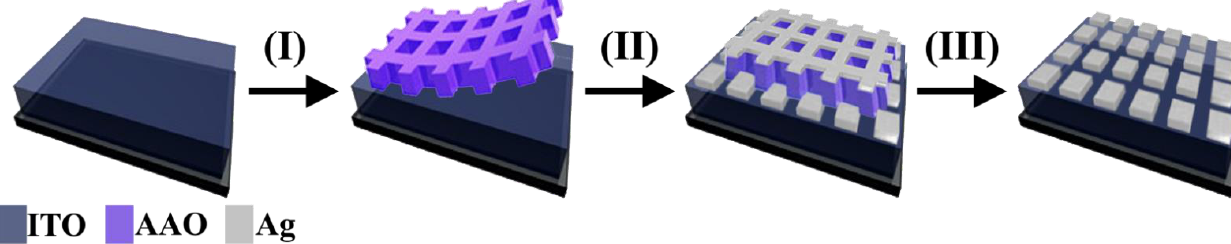
Figure 1. The fabrication scheme of the Ag nanosquare array. Step I: manually transfer UTAM on top of ITO. Step II: deposit Ag on UTAM using the DC sputtering method. Step III: remove UTAM using clear tape.